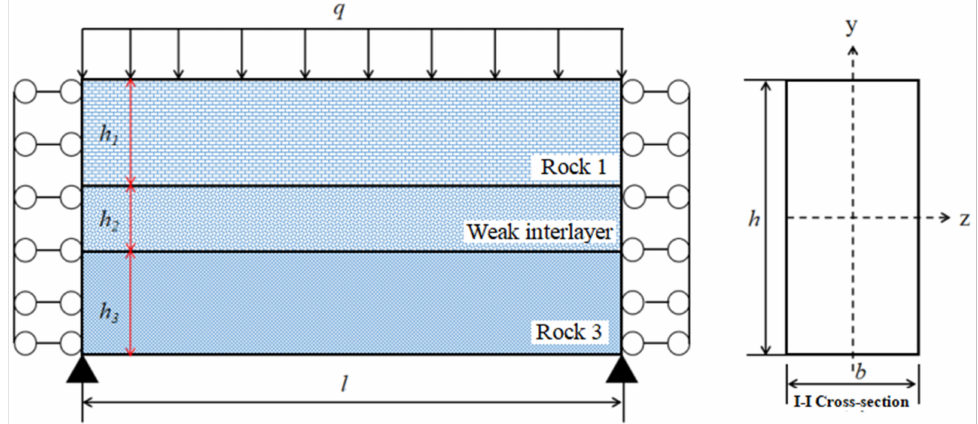
Figure 5. Rock beam